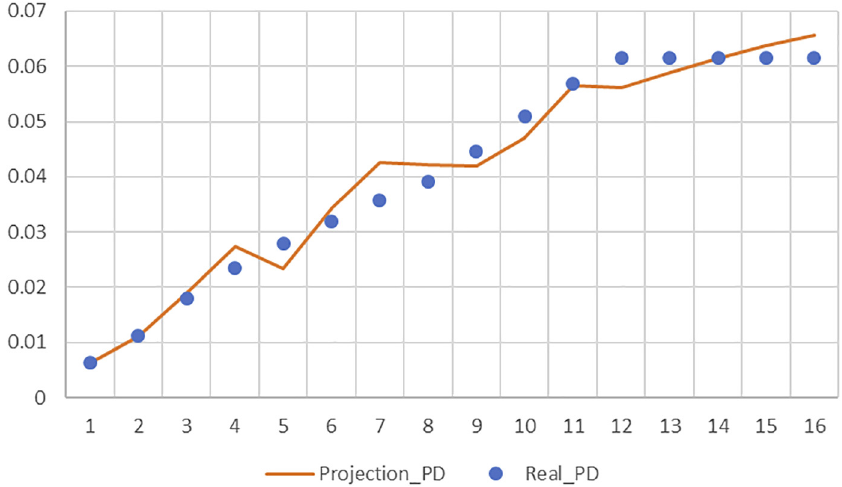
Table IV. Example of the back test results on the working capital segment with smoothing coefficient